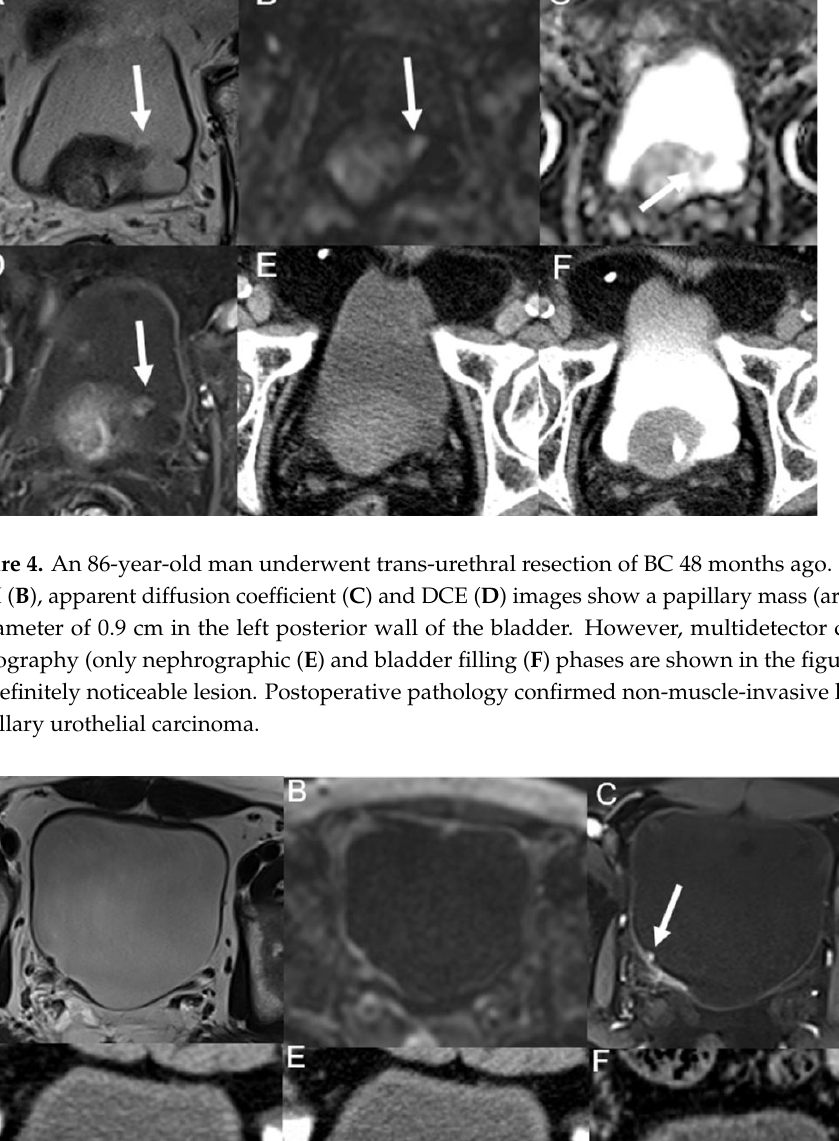
Figure 3. A 71-year-old man underwent trans-urethral resection of BC 42 months ago. MRI ( A – C ) and MDCT ( D – F ) show a papillary mass (black arrow) in median posterior wall of the bladder. A micro-nodule (white arrow) in the right posterior wall is visible on DWI ( A ) and DCE ( B ) images. Another tiny polypoid lesion (blue arrow) in the right posterolateral wall is visible on another layer of DCE-MRI ( C ). None of the two small lesions is visible on unenhanced ( D ), nephrographic ( E ), excretory ( F ) phases of MDCT. Postoperative pathology of all the lesions were non-muscle-invasive low-grade papillary urothelial carcinoma.